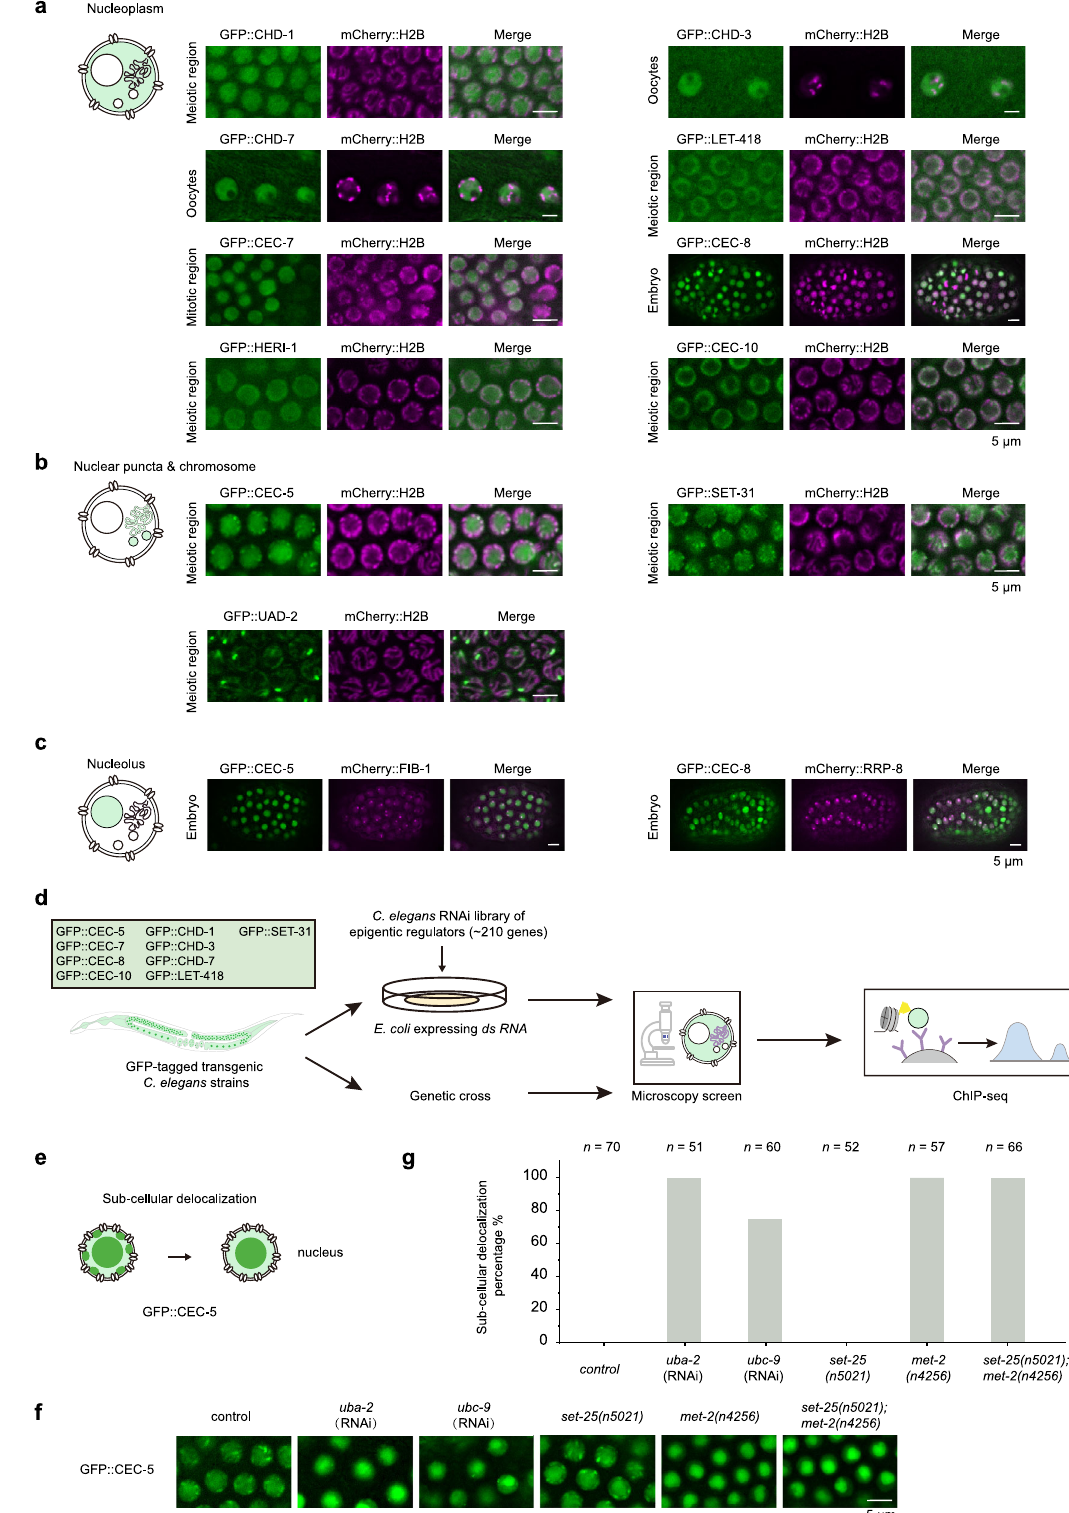
Fig. 4 | A candidate-based RNAi screening to search regulators of chromodo- main proteins. a – c The three distinct subcellular localization patterns of chro- modomain proteins. a Nucleoplasm in the germline. b Nuclear puncta and chromosomes in the germline. c Nucleolus in embryos. The localization of a representative image for each chromodomain protein is shown (scale bar, 5 μ m). The chromosome is marked by mCherry::H2B, and the nucleolus is marked by mCherry::FIB-1 or mCherry::RRP-8. d Schematic procedure of the candidate-based